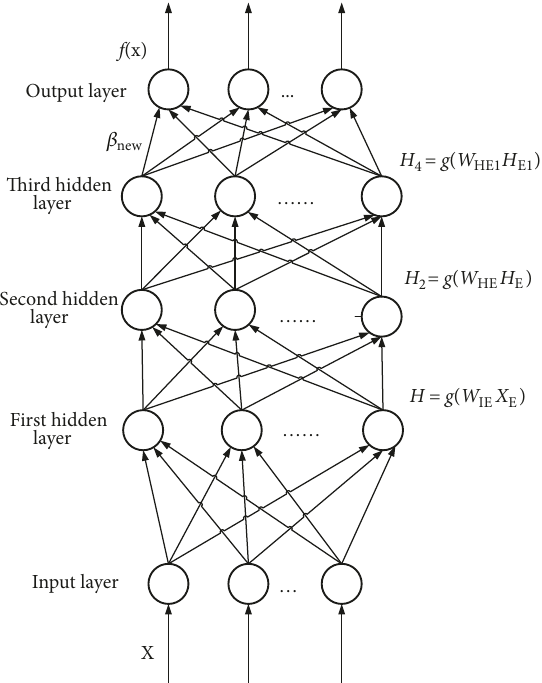
Figure 2: The structure of the MELM